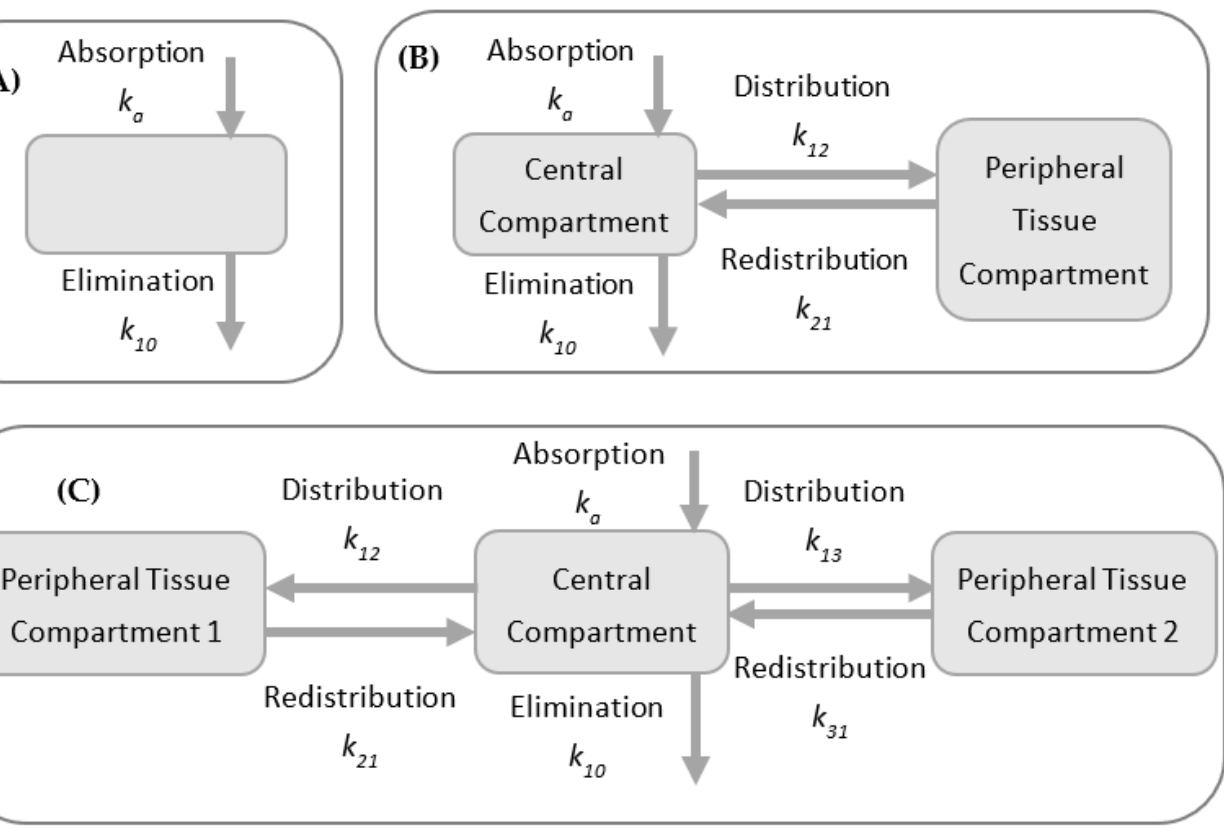
Figure 4. Schematic comparison between models with ( A ) 1, ( B ) 2, and ( C ) 3 compartments; first-order rate transfer constants for drug absorption ( k a ), movement of drug between compartments ( k 12 , k 21 , k 13 , k 31 ), and drug elimination ( k 10 ) are indicated.